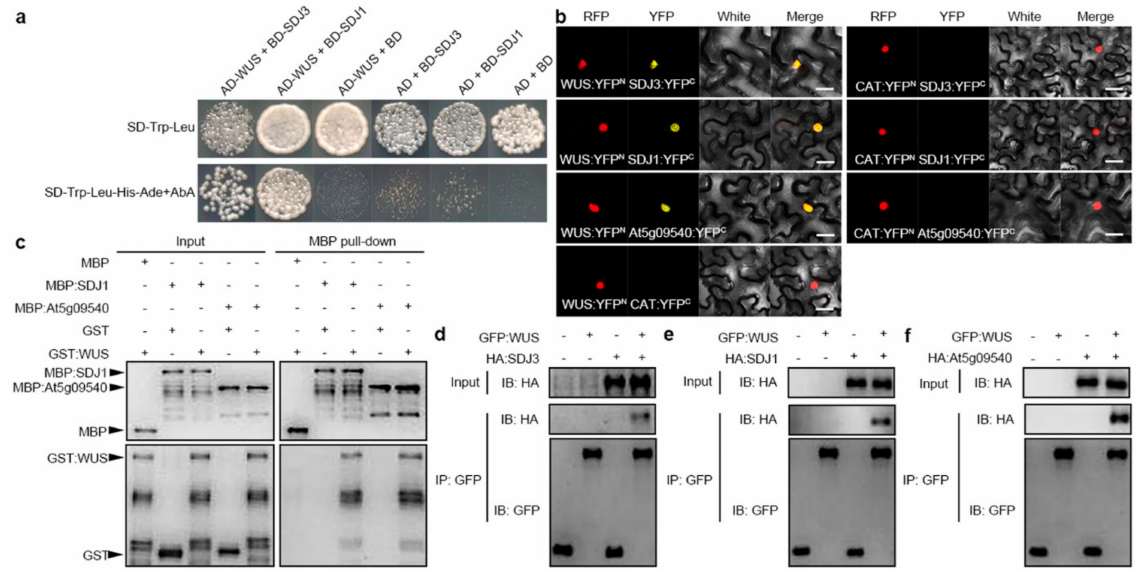
Figure 1. WUS protein interacts with DnaJ proteins ( a ) WUS protein interacts with SDJ1 and SDJ3 proteins in Yeast- two-hybrid assays. ( b ) Bimolecular fluorescence complementation in tobacco epidermal cells. WUS:YFPn protein in combination with SDJ3:YFPc, SDJ1:YFPc, and At5g09540:YFPc, respectively, was colocalized with Coilin:RFP protein in nucleus. CAT:YFPn and CAT:YFPc were used in control assays. Scale bar = 25 µ m. ( c ) Input of recombinant proteins detected by immunoblotting with anti-GST antibody and anti-MBP antibody (Left) and pull down of GST-tagged WUS protein through MBP-tagged SDJ1 and MBP-tagged At5g09540 proteins detected by immunoblotting with anti-GST antibody (right). ( d – f ) Co-immunoprecipitation of GFP:WUS and HA:SDJ3 ( d ), GFP:WUS and HA:SDJ1 ( e ), GFP:WUS and HA:At5g09540 ( f ) detected by immunoblotting with anti-HA